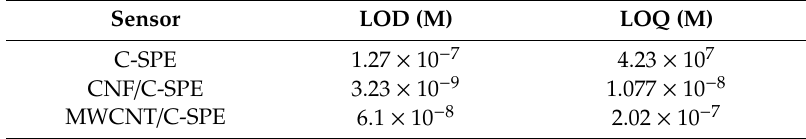
Table 6. LOD and quantification limit (LOQ) values for ca ff eic acid detection for each of the three